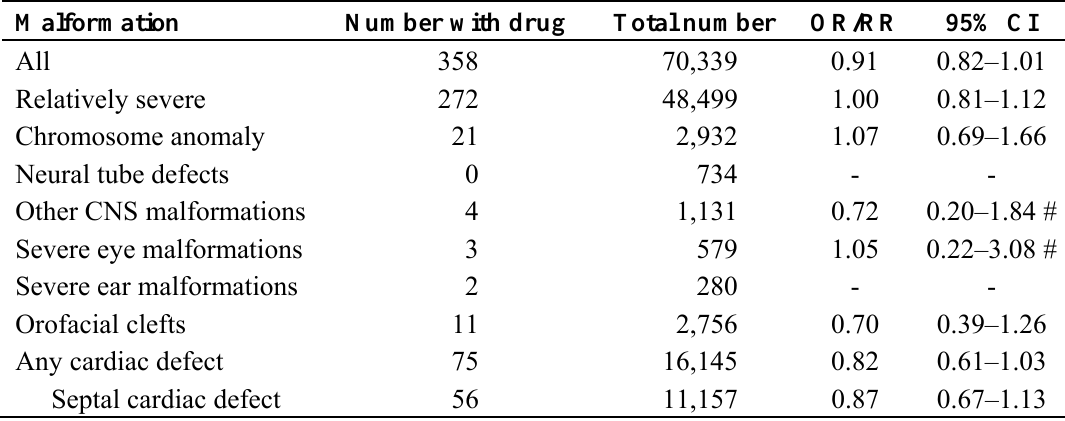
Table 24. Congenital malformations in infants whose mothers had used sedatives or hypnotics in early